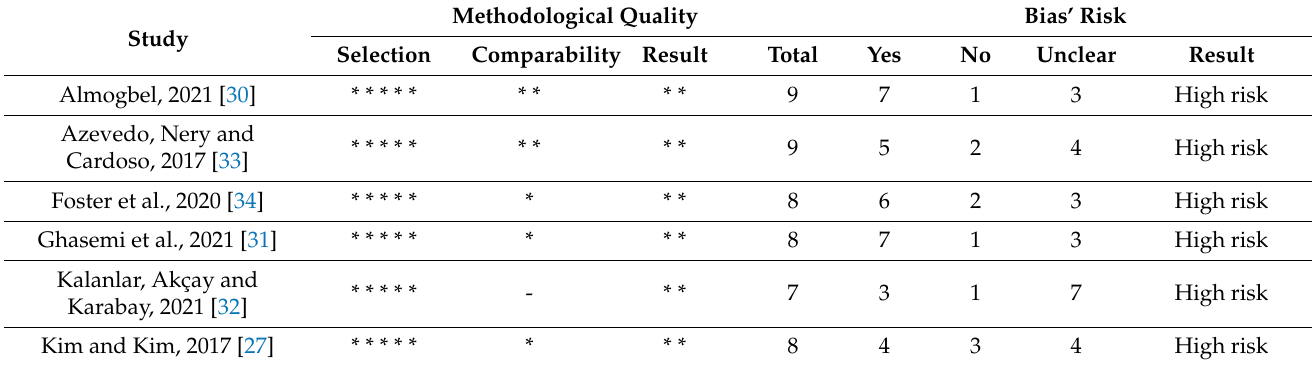
Table A1. Assessment of Methodological Quality and Risk of Study